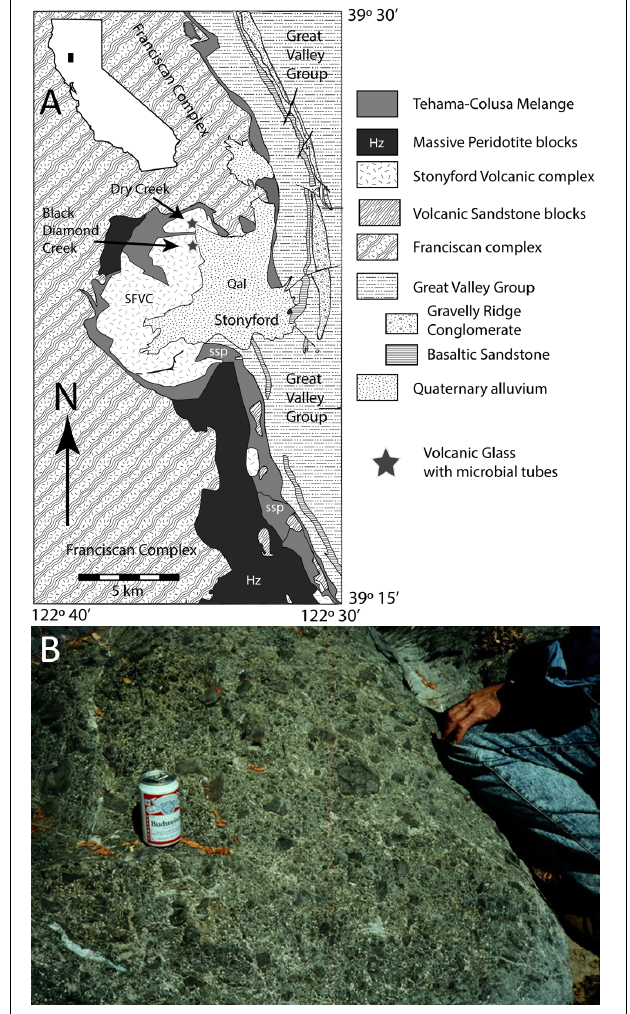
FIGURE 1 | (A) Map showing location of glass-rich horizons in the Stonyford Volcanic Complex (SFVC), which crop out in Dry Creek (glass samples G1–G4) and near Black Diamond Creek (glass samples G5, G8). The SFVC is separated from the high P/T Franciscan complex by a serpentinite mélange (Shervais et al., 2011). Map adapted from Shervais et al. (2011). (B) Example of hyaloclastite (G3), showing outcrop-scale textures. Field hydration equipment for